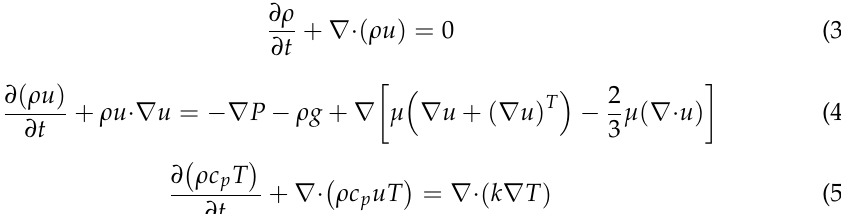
where u is the fluid velocity vector. P is the pressure; µ is the kinetic viscosity; and ρ is the fluid density, which is a temperature-dependent function, described as follows: